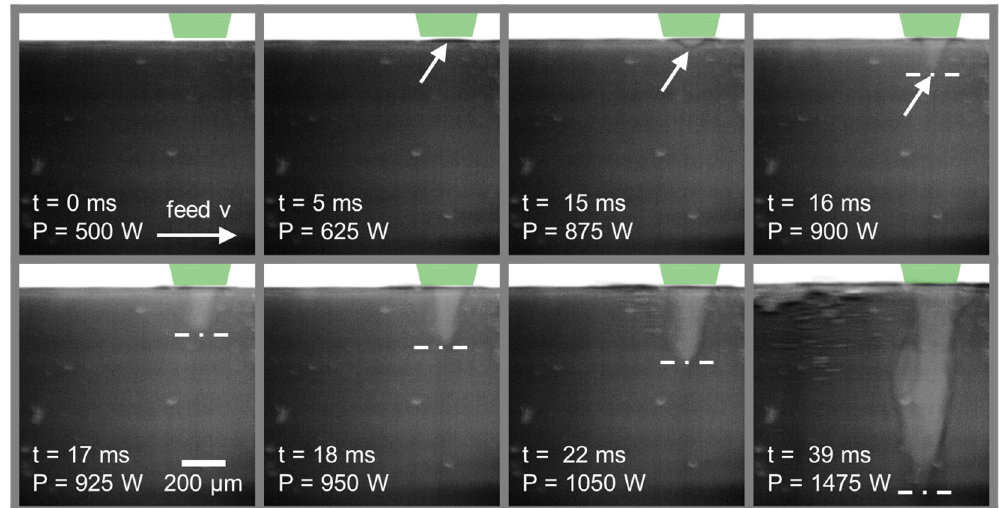
Figure 4. X-ray video sequence of laser beam welding of copper using 515 nm laser radiation, P = 500 W–1500 W, v = 66.7